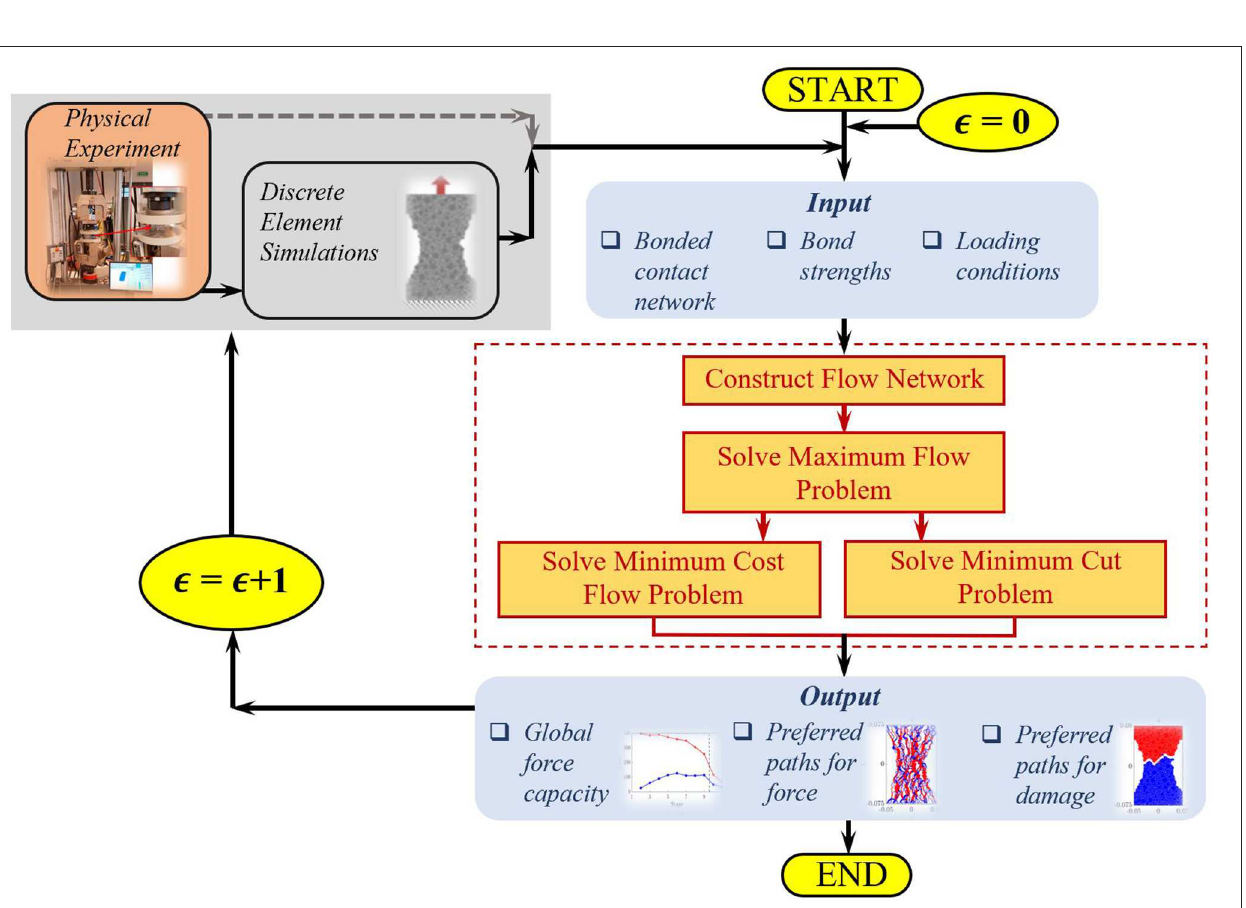
FIGURE 5 | (Color online) Leveraging microstructural data assets on heterogeneous solids. Flow chart summarizing the network flow framework for prediction of force and damage propagation patterns from data across the various stages of the loading history ǫ = 1,2,.., r . In this study, data were derived from DEM simulations of the experiments of Van Vliet and Van Mier (1999) on concrete under uniaxial tension, with attention paid to the meso-scale structure of real concrete using Xray µ CT images.